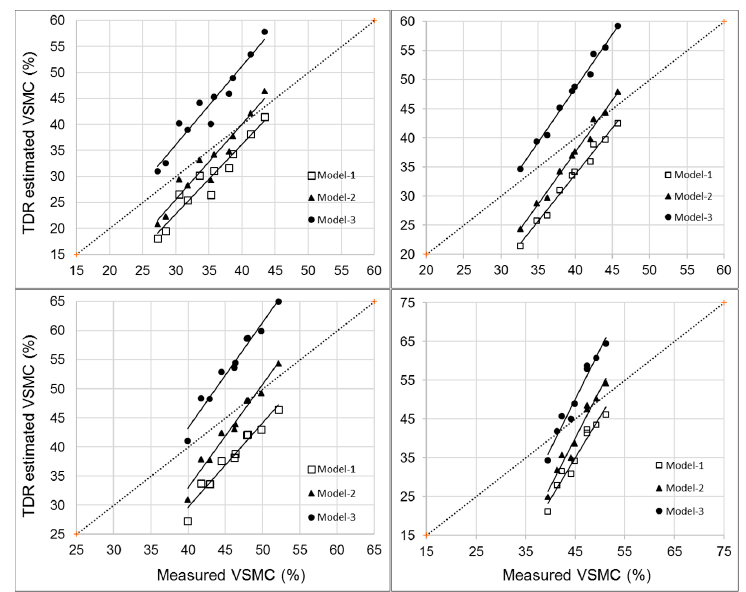
Figure 4. Relationship (1:1 graph) between the measured and TDR (Time-domain reflectometer)-estimated volumetric soil moisture content (VSMC) using three models; M-1, M-2, and M-3, for powdered biochar (BC P ) at 15% ( top-left ), 20% ( top-right ), 40% ( bottom-left ), and 50% ( bottom-right ) rates (NOTE: No data are available for granular biochar (BC G ) with these corresponding rates).